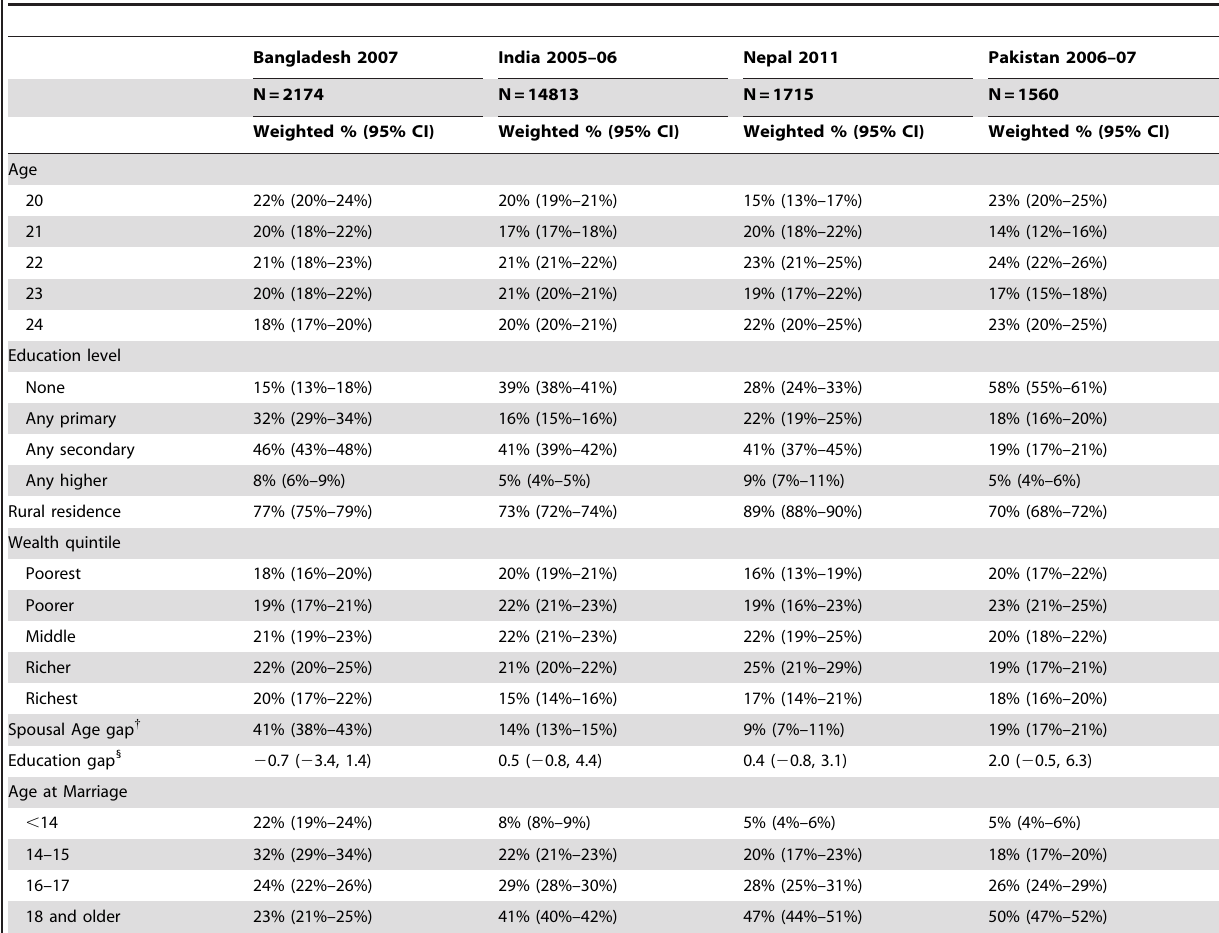
Table 1. Demographic profiled of ever-married women aged 20–24 years for most recent Demographic Health Survey data from Bangladesh, India, Nepal, and